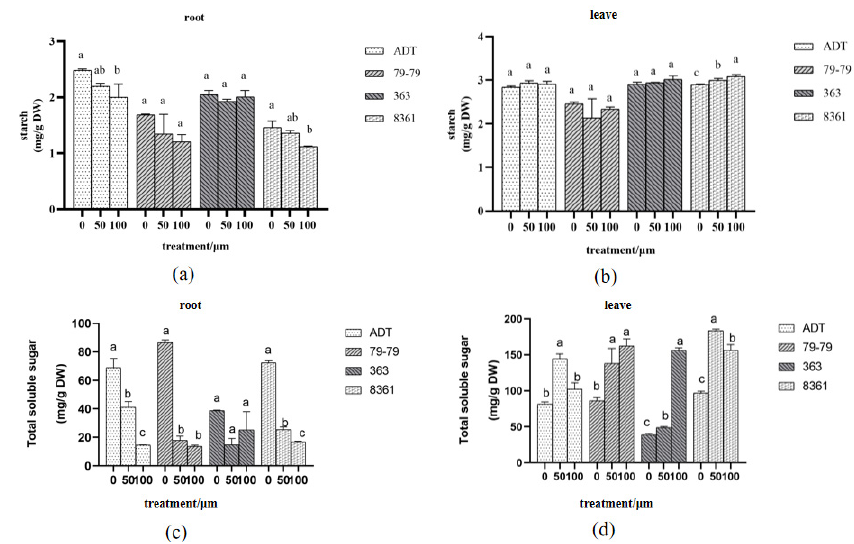
Figure 7. Changes in the starch ( a , b ) and total soluble sugar ( c , d ) content in the roots and leaves of plants treated with cadmium. Within each sunflower species, the different letters indicate a significant difference at the p < 0.05 level, according to Duncan’s multiple range test.